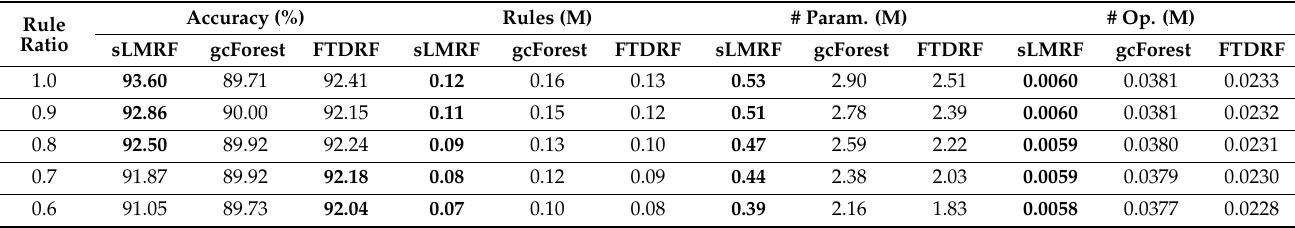
Table 2. Comparison of accuracy, number of rules, number of parameters (#Param.), and number of operations (#Op.) between DRF models according to the rule ratios using the CK+ dataset. The rule ratio 1.0 of sLMRF is the same as that of